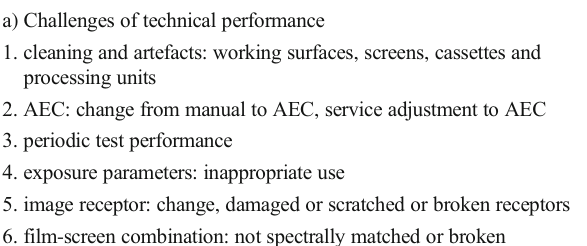
Biggest challenges of breast imaging practice according to selected studies a) Challenges of technical